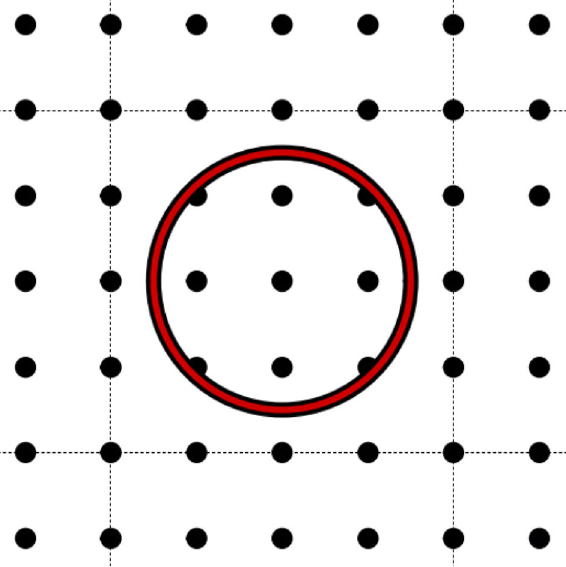
Figure 3. Representation of a 5 × 5 unit cell and the circular